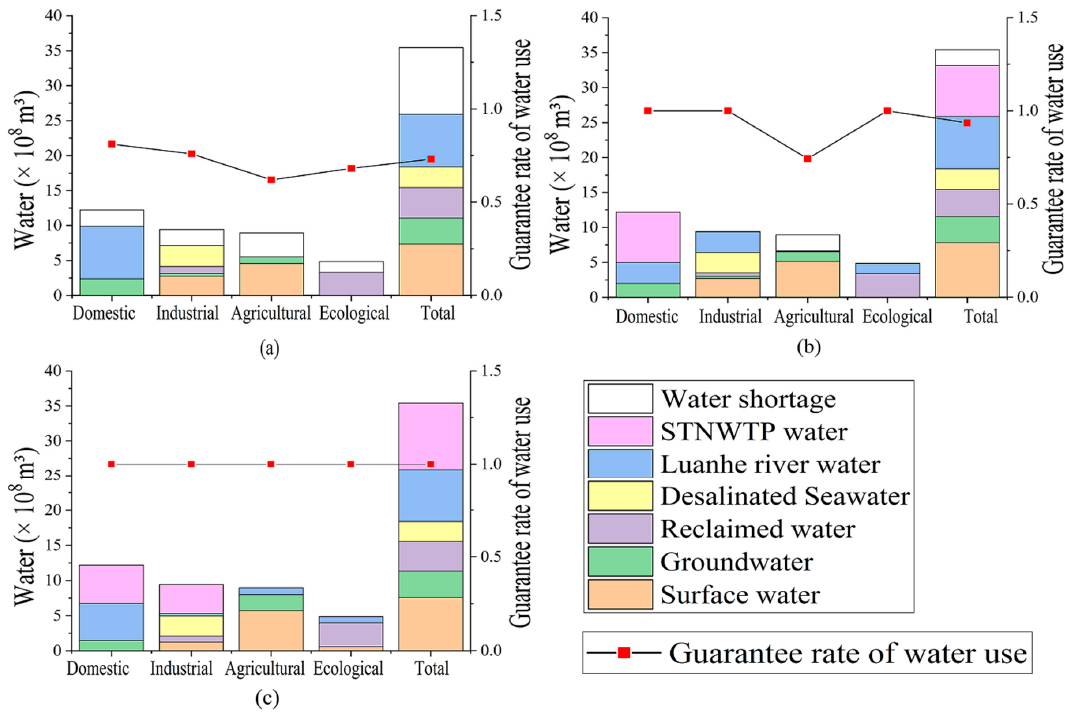
Figure 6. The guarantee rate of water use in Tianjin for: ( a ) (surface water 50% + Luanhe river water 75%); ( b ) (surface water 50% + Luanhe river water 75% + STNWTP water 95%); ( c ) (surface water 50% + Luanhe river water 75% + STNWTP water 75%).